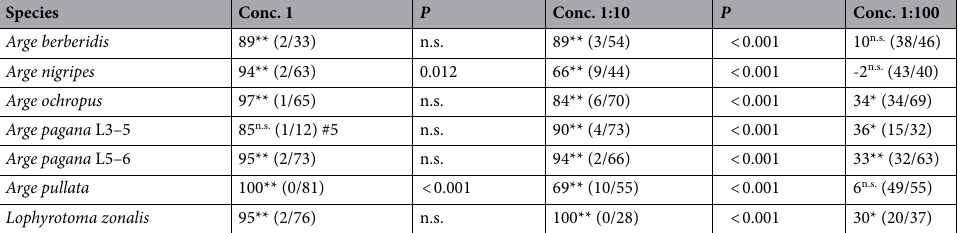
Table 4. Deterrence rates of crude hemolymph from sawfly larvae tested at three concentrations on ant Myrmica rubra . Deterrence of the hemolymph was compared with the control. Hemolymph was used at three concentrations (Conc.). Larvae at instars 3 to 5 (L3-5) or 5 and 6 (L5-6). Each test was repeated 12 times, except for one sample with five repetitions (#5). Data for A. pagana L5–6 are from Petre et al. (2007) 17 . Values at each concentration are given as percentages of deterrence rate, with total numbers of ants on hemolymph vs. control droplets given between parentheses. Statistical results under each concentration are from Wilcoxon signed-rank tests, two-tailed: P > 0.05 (n.s.), P < 0.05 (*), P < 0.01 (**). Statistical results between two table columns compare the data from these columns, by Fisher exact probability tests, two-tailed: P > 0.05 (n.s.).